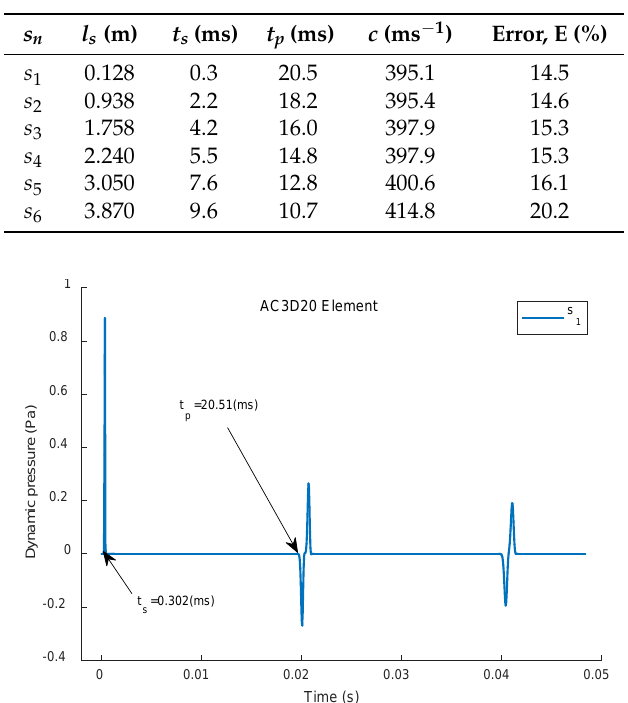
Figure 7. Enlarged view of pressure vs. time response predicted at sensor s 1 using AC3D20 type. element Table 1. Arrival Time of Compression and Rarefaction Wave-front using the acoustic continuum 3D 20-node brick elements (AC3D20).